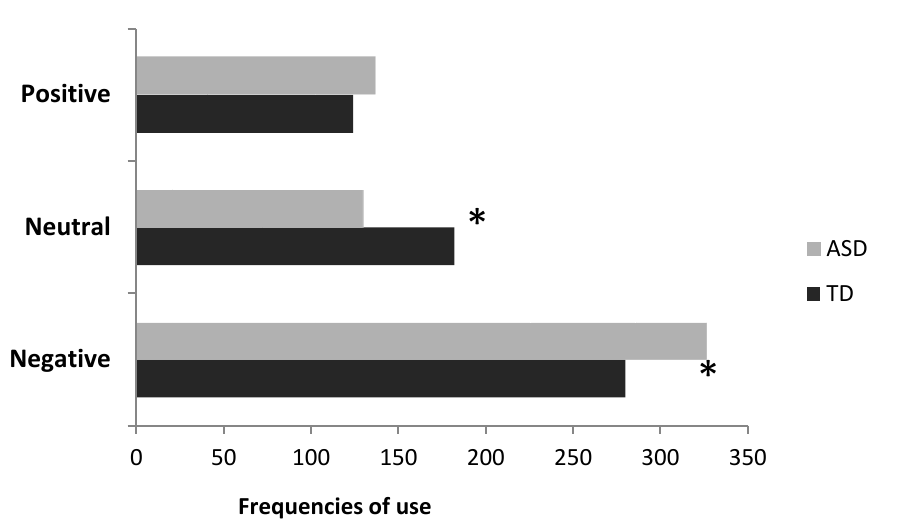
Figure 2. Frequency of use of terms corresponding to a neutral, a negative or a positive affective state distinguished by autism spectrum disorders (ASD) and TD participants. Asterisks represent statistically significant effects.